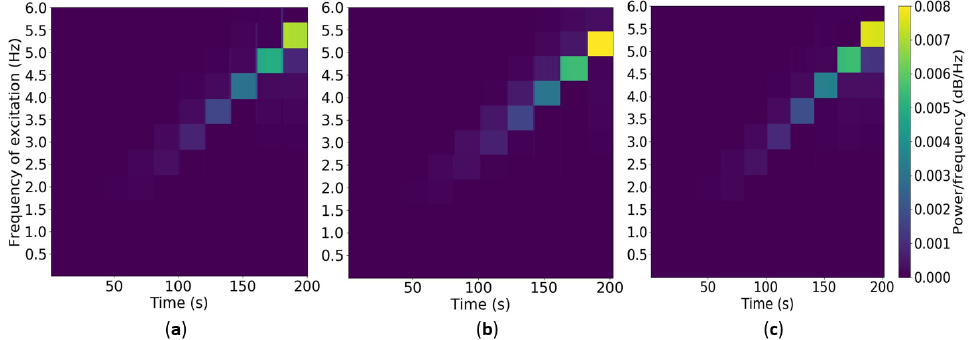
Figure 15. Spectrograms for the 0.10 cm displacement frequency chirp: ( a ) PCB L74 spectrogram. ( b ) ADXL355 RBP1 spectrogram. ( c ) ADXL355 RBP4